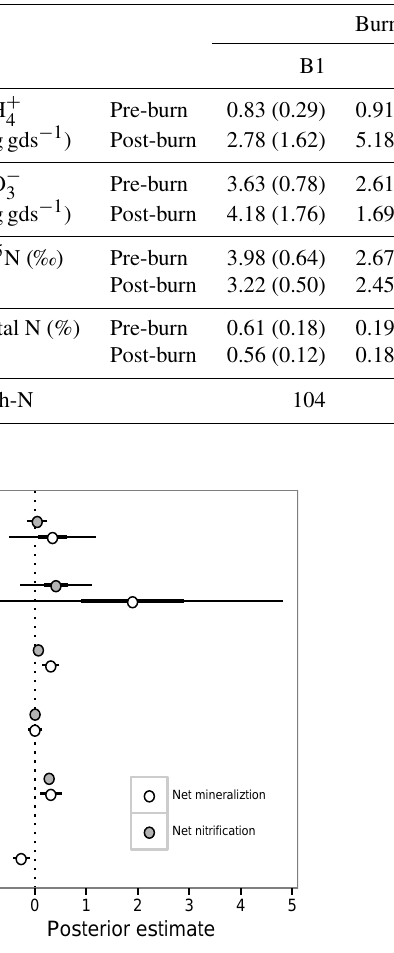
Figure 8. Estimates of parameter posterior mean effects with bars showing 95% CI for net mineralization and net nitrification rates. Parameters are days since fire (DSF), soil pH, soil moisture (SM), soil organic matter (SOM), the incubation length (Inc.), and initial substrate availability ( S 0 ) per gram of dry soil (gds). For visual clar- ity, posterior distributions of site effects are not included here. See text for